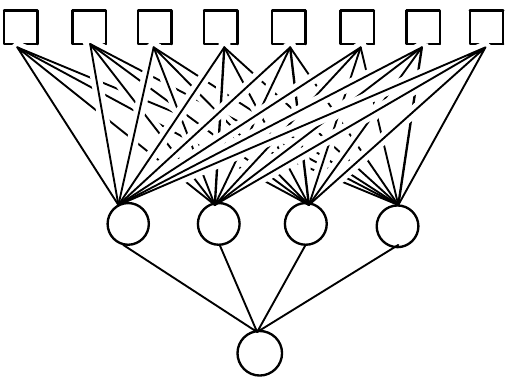
Figure 2. 8-4-1 architecture of a three-layer neural